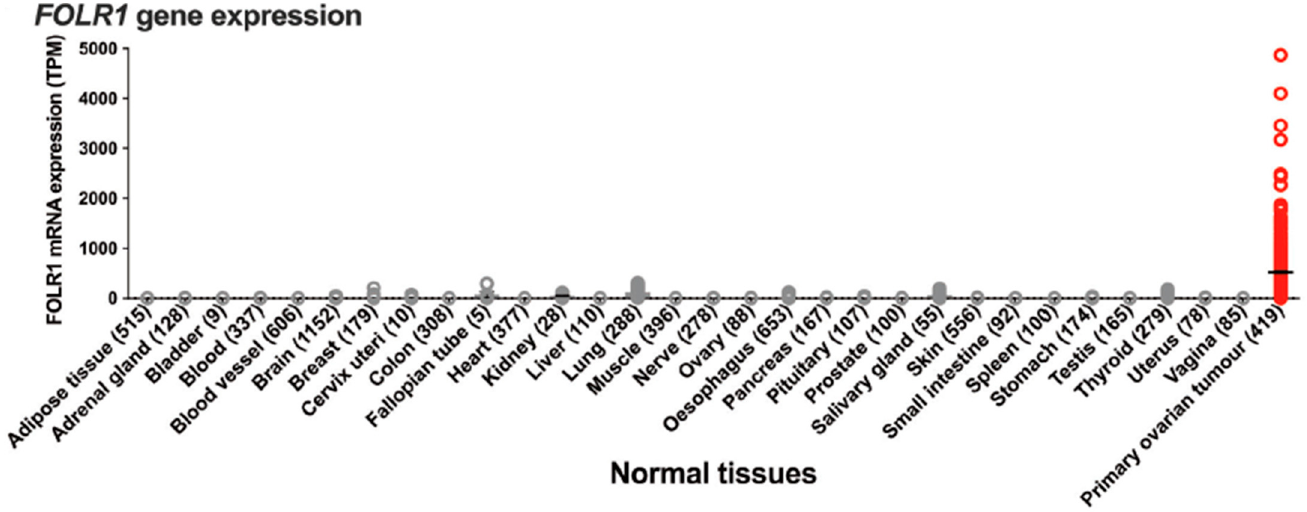
Figure 12. Tissue/organ distribution of FOLR1 in normal tissues and ovarian cancer, reprinted from